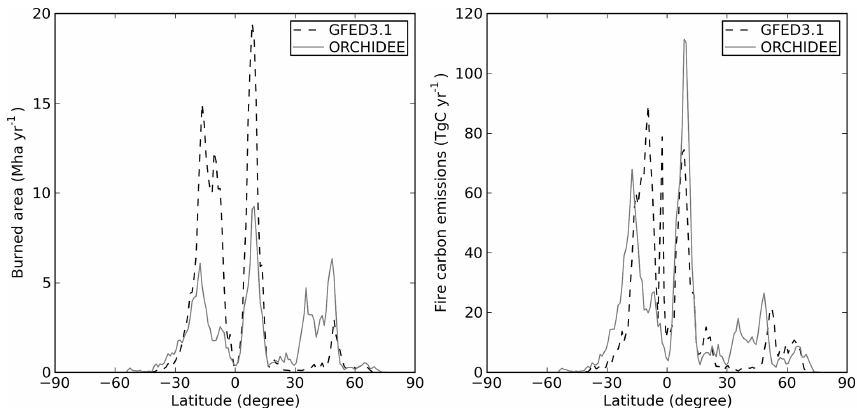
Figure 7. The latitudinal distribution of (a) burned area and (b) fire carbon emissions as simulated by ORCHIDEE (grey solid line) and by the GFED3.1 data (black dashed line).